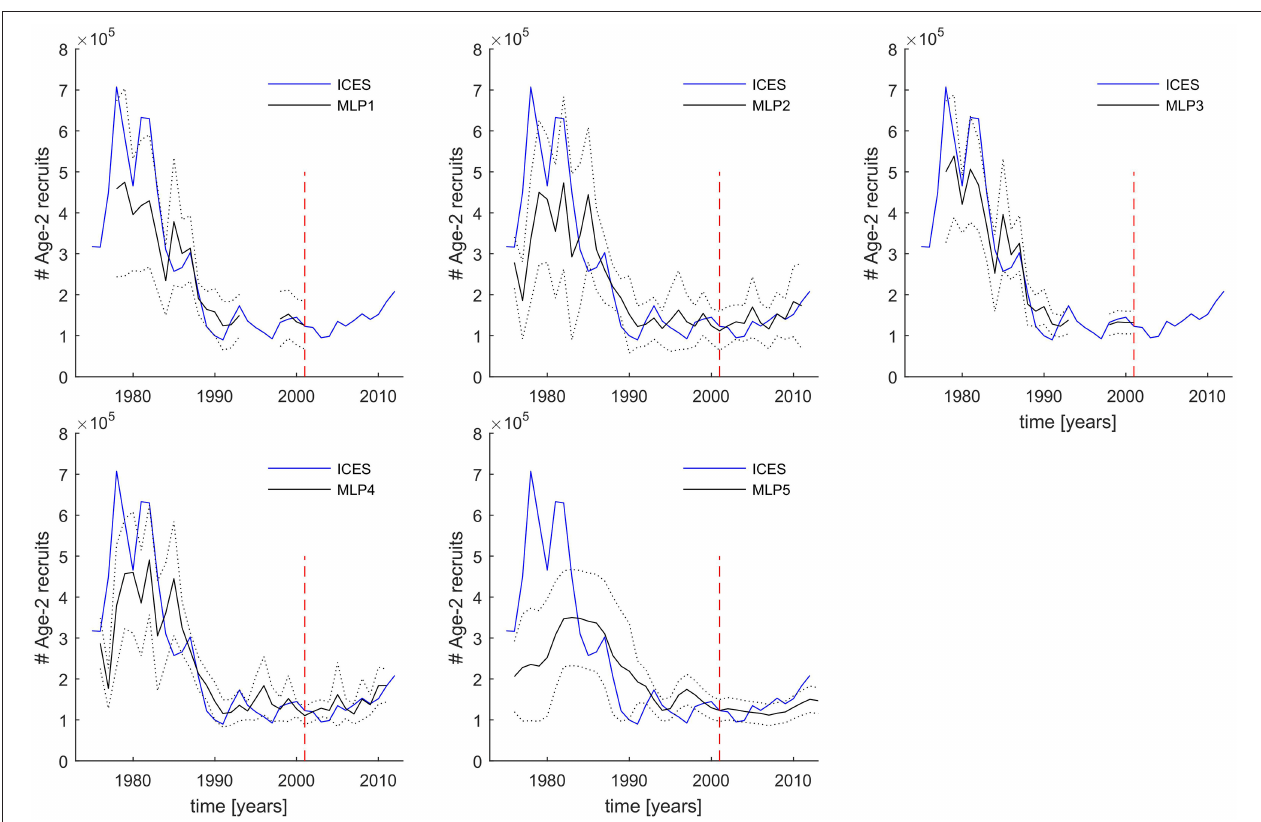
FIGURE 7 | 1976–2011 time-series predictions of five different FishANN MLP structures compared to the ICES number of Age-2 recruits. Gaps in prediction time series are caused by missing input variables at those years. Solid blue lines—ICES reference values in numbers of individuals. Solid black lines are the MLP ensemble model median predictions. Dotted black lines mark the confidence intervals of the MLP predictions equivalent to ± 2 standard deviations of the predictions from all 35 ensemble members. The dashed red vertical line separates the time period used for every MLP model training and evaluation (left of the line) from the time period used as a completely independent test data set (right of the line) not used at all during the cross-validation